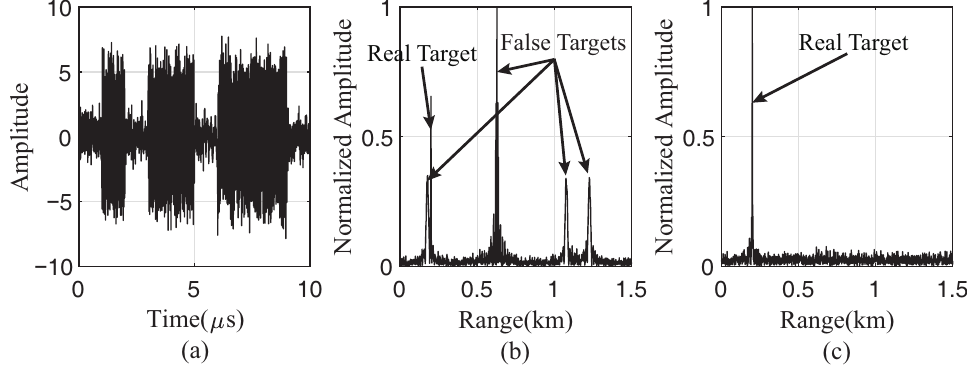
Figure 6. Simulation results of TMF for ISCRJ. ( a ) The echo signal with ISCRJ; ( b ) pulse compression of the echo signal; ( c ) pulse compression of echo signal after